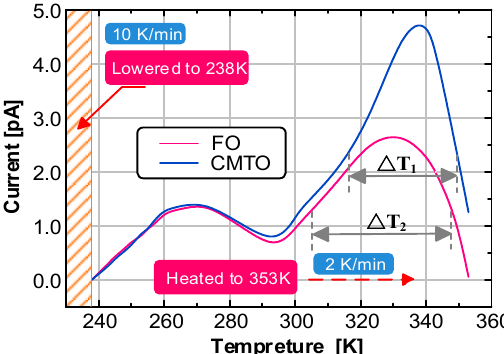
Figure 10. TSC test results of FO and CMIO.